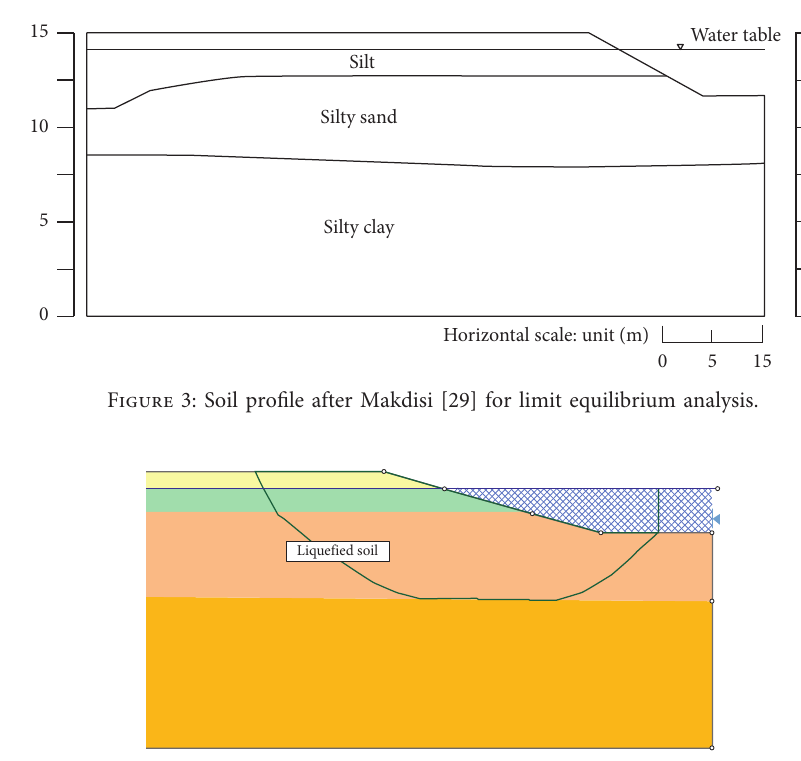
Figure 4: Postliquefaction yield acceleration of wildlife site. Table 2: Lateral spreading calculated by the simplified method (the reported displacement is reported as 0.18